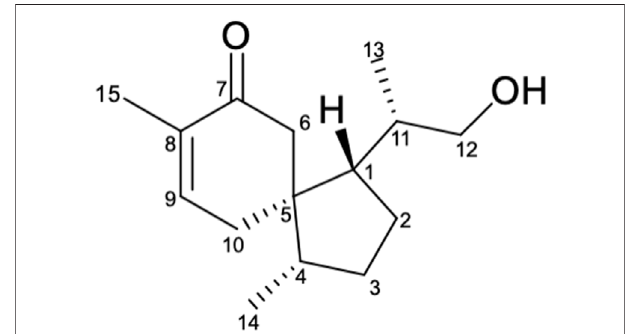
FIGURE 1 | Structure of compound